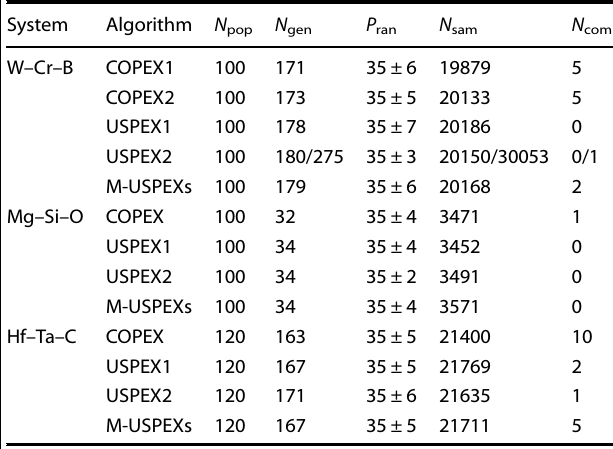
Table 1. Benchmark tests using crystal structure prediction algorithms COPEX and USPEX applied to different systems at ambient pressure.